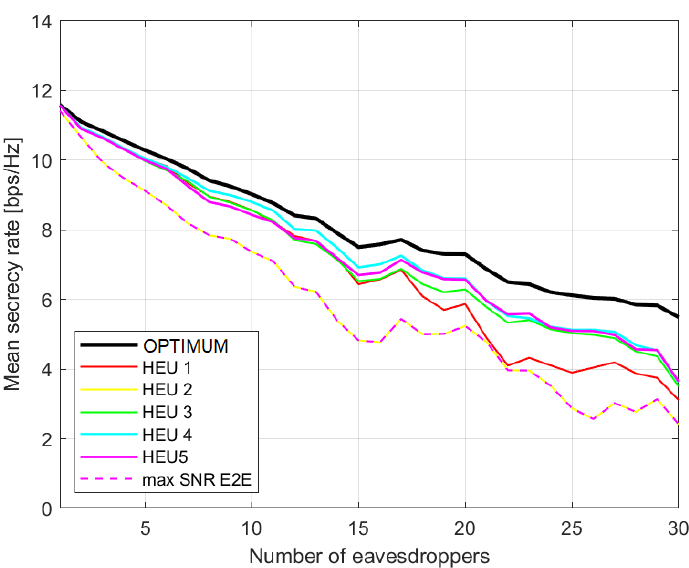
Figure 2. Average secrecy rate with regards to number of eavesdroppers for different approaches. Scenario (c) with cooperative eavesdroppers.